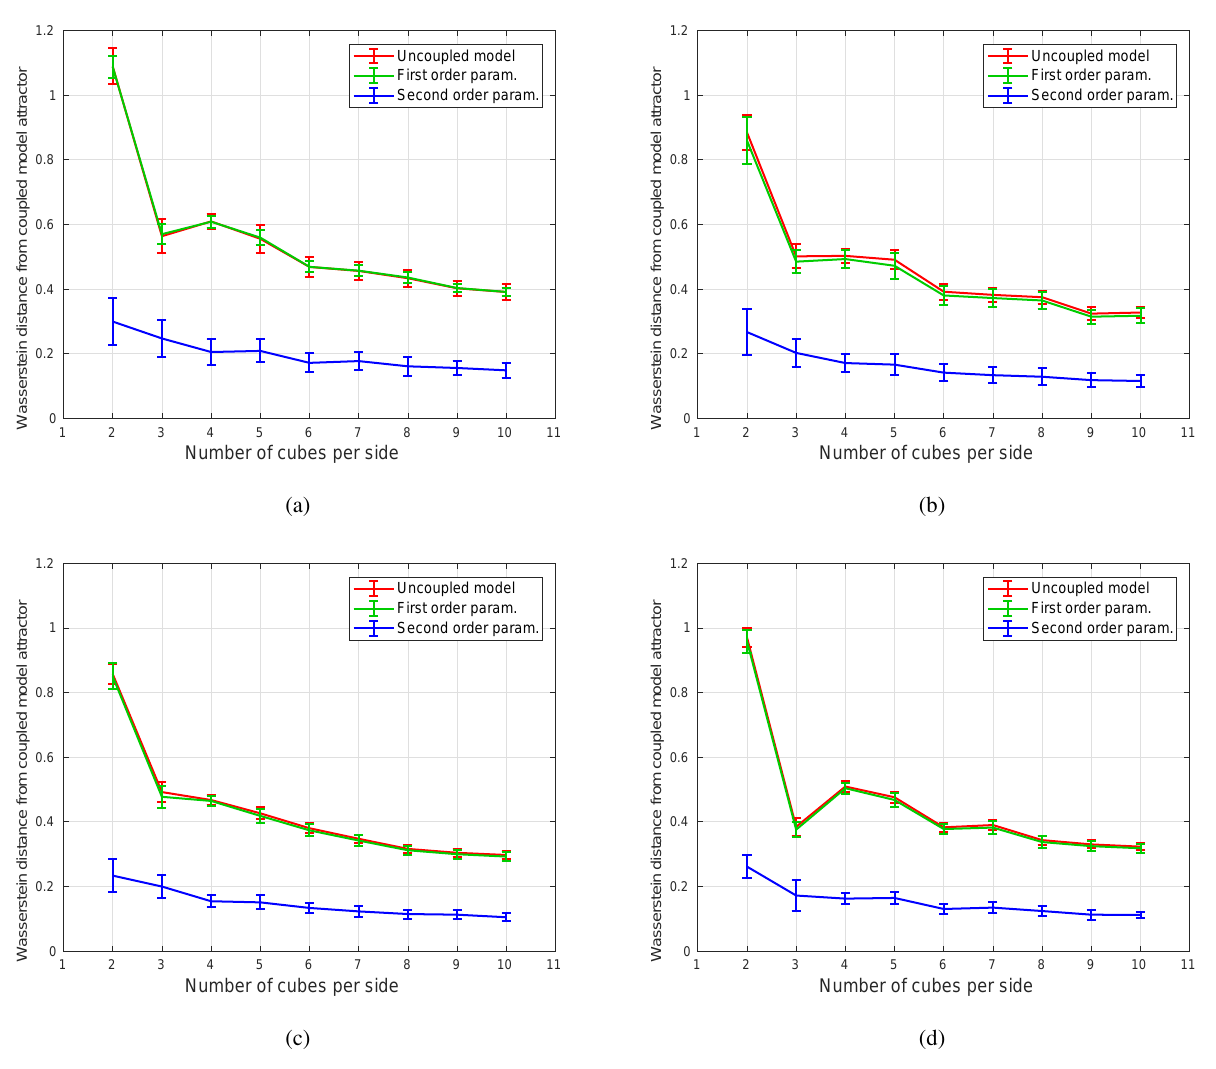
Figure 7. Wasserstein distances from the coupled model with respect to number of cubes per side: (a) 3-D case, (b) projection onto XY plane, (c) projection onto XZ plane, and (d) projection onto YZ plane. For case τ = 5, the Lorenz 63 model acts as a fast forcing on the Lorenz 84